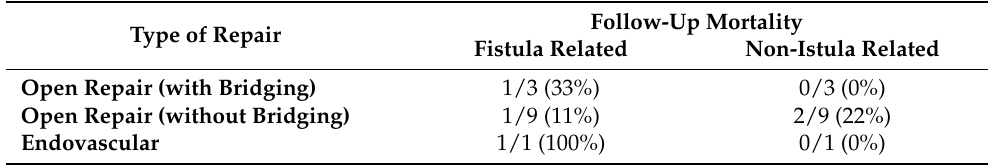
Table 4. Mortality of patients who survived the perioperative period, depending on type of repair and fistula